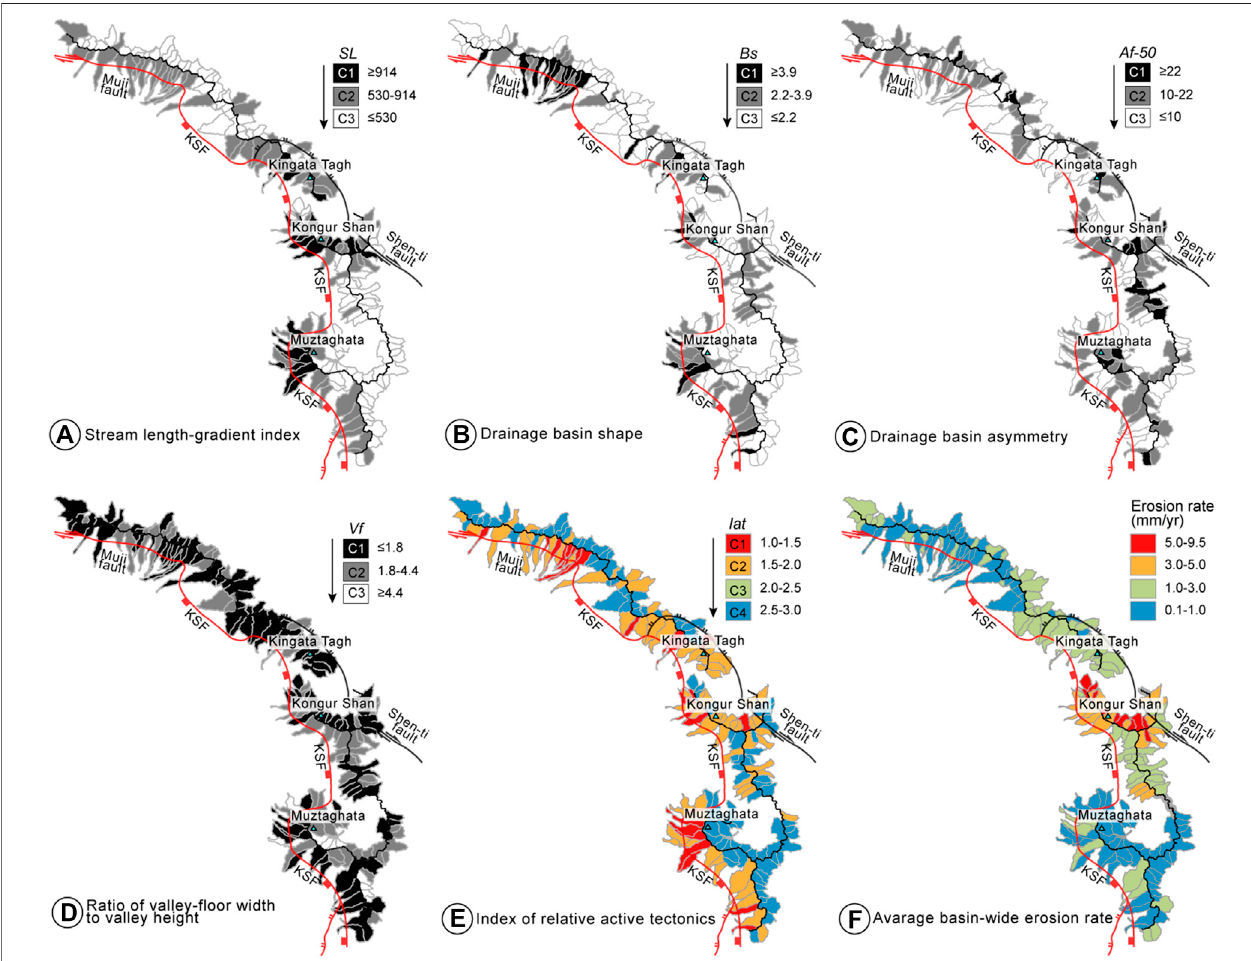
FIGURE 6 | Spatial distribution of various morphometric indices for basins along eastern Pamir range. (A) SL , (B) Bs , (C) Af-50 , (D) Vf , (E) Iat , and (F) average basin-wide erosion rates. Arrows point to intensity of tectonic activity from relatively strong to weak.